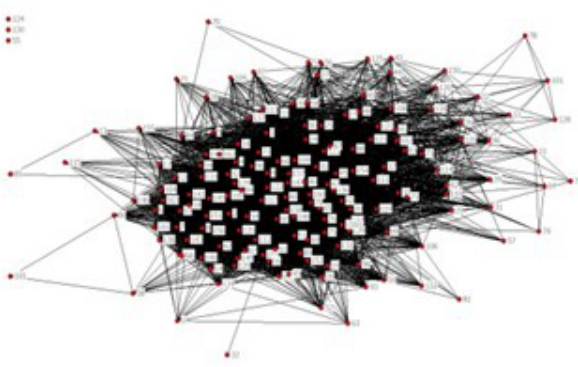
Figure 3. The SSE 180-Index Sample Stock Network Topology with Threshold 0.4